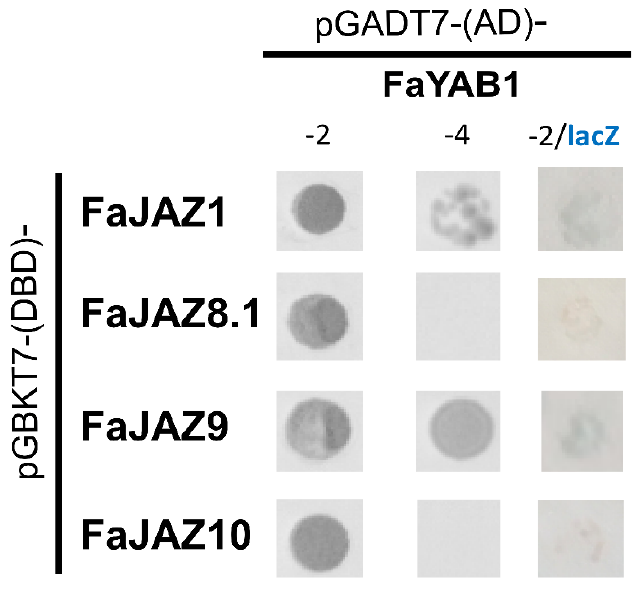
Figure 4. Protein–protein interactions of Fragaria × ananassa JASMONATE ZIM-DOMAIN (FaJAZs) repressors with the F. × ananassa YABBY1 (FaYAB1) transcription factor. FaJAZ1, FaJAZ8.1, FaJAZ9, and FaJAZ10 were cloned into pGBKT7-(DBD)-Gateway vector. FaYAB1 was cloned into the pGADT7-(AD)-Gateway vector. -2, SD-Leu-Trp; -4, SD-Leu-Trp-His-Ade; AD, activation domain; DBD, DNA binding domain; lacZ, β -galactosidase gene. FaJAZ1, F. × ananassa JAZ1; FaJAZ8.1, F. × ananassa JAZ8.1; FaJAZ9, F. × ananassa JAZ9; FaJAZ10, F. × ananassa JAZ10; FaYAB1, F. × ananassa